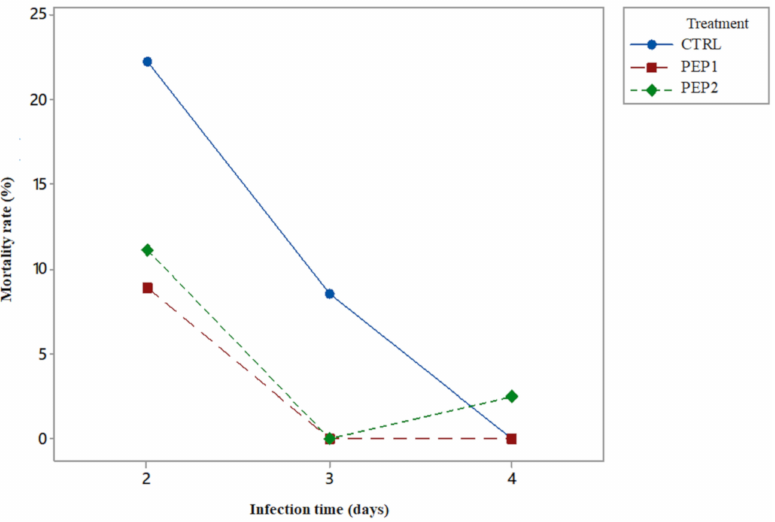
Figure 4. Mortality rate as a function of time of